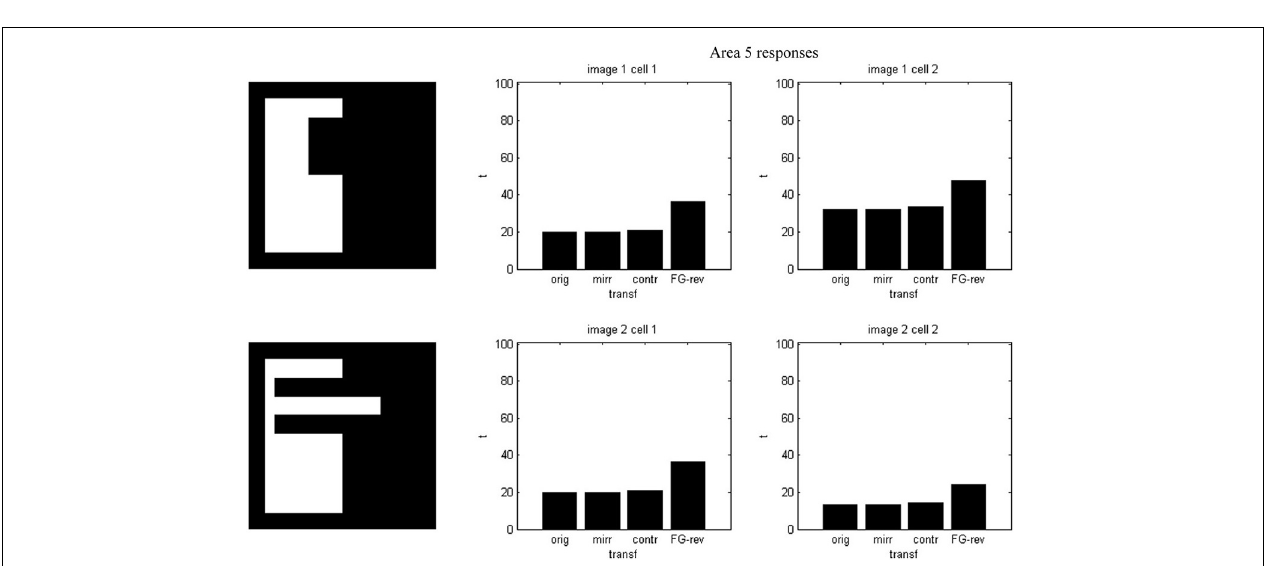
FIGURE 4 | Spike counts for the example of Figure 2. Each plot corresponds to an image set and an area 5 cell. In every case there are fewer spikes for FG-reversal.